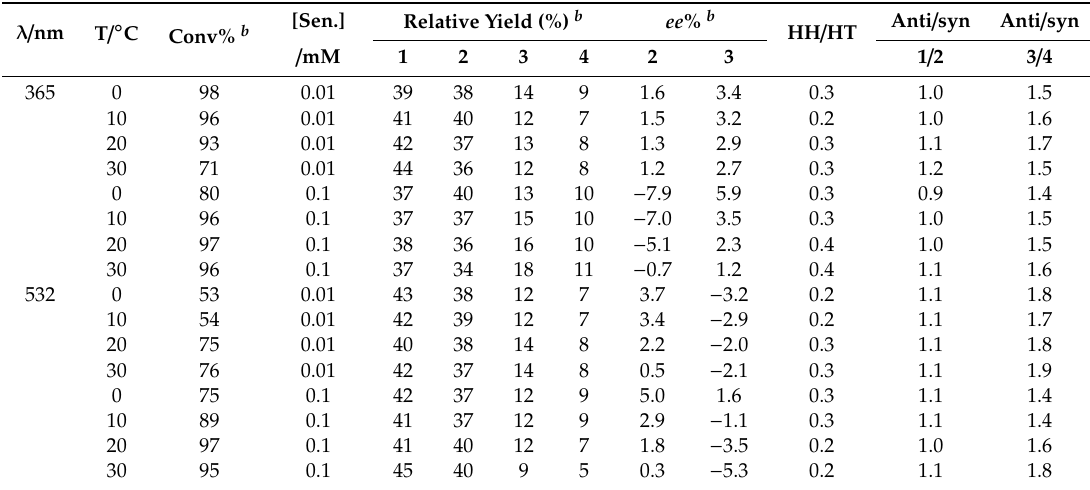
Table 2. Photocyclodimerization of AC (0.2 mM) with Pt-2 as the sensitizer / host under di ff erent temperatures a .